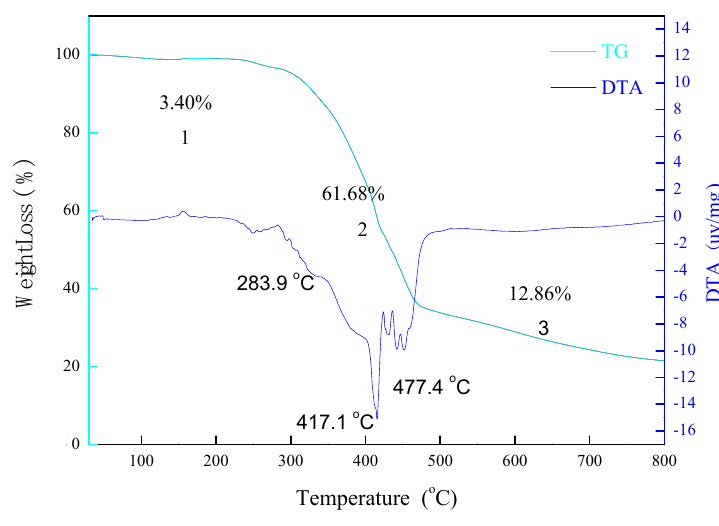
Figure 3. TG analysis of di-[EMIM]CoCl 3.